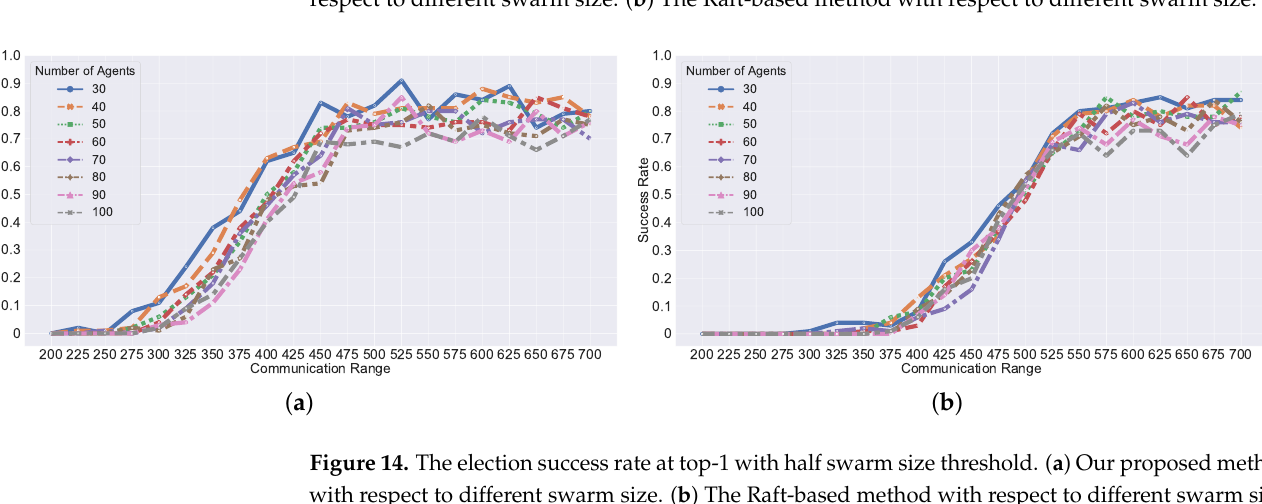
Figure 13. The election success rate at top-1 with 15-vote threshold. ( a ) Our proposed method with respect to different swarm size. ( b ) The Raft-based method with respect to different swarm size.